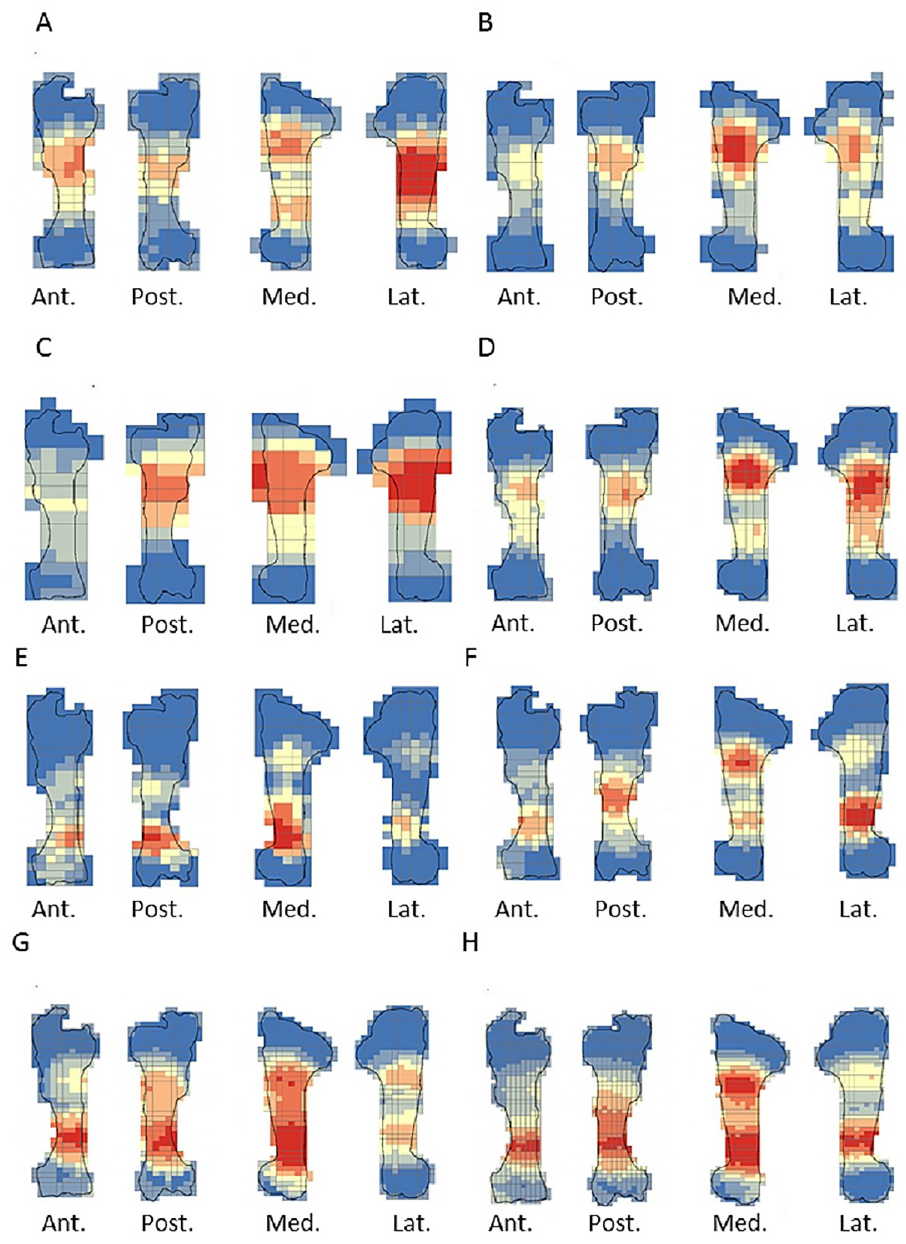
Fig 6. Optimized hot spot analysis of combined percussion marks from the humerus in each series. A-E- Individual n˚1; B-F- Individual n˚7; C-G- Individual n˚11; D-H- Merged humerus series; A, B, C and D: “CNA” Percussion marks and E, F, G and H: pits and grooves (Ind.: